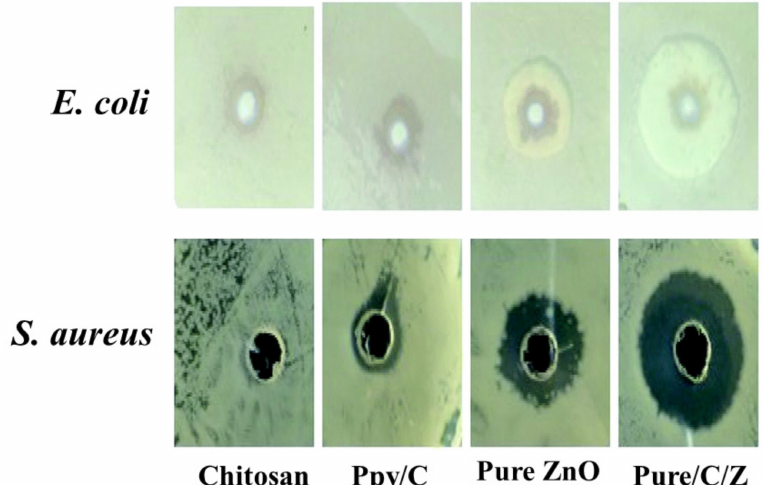
Figure 2. Zone of inhibition of chitosan, PPy/C, Pure ZnO (Z), and PPy/C/Z against E. coli and S. aureus . (Reprinted from Ref.